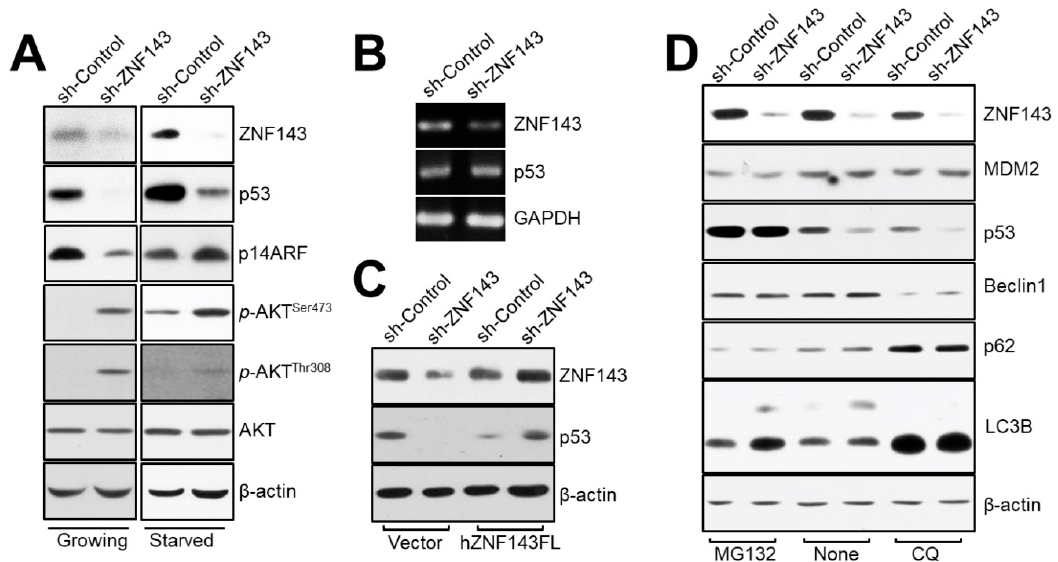
Figure 4. The p53 protein is altered in MCF7 sh-ZNF143 cells in a proteasome-dependent manner. ( A ) Growing or FBS-starved cells were harvested and subjected to immunoblotting. ( B ) Growing cells were harvested for RT-PCR. ( C ) Growing cells were transfected with pFLAG-CMV-hZNF143 or empty vector for 24 h and harvested for immunoblotting. ( D ) Growing cells were harvested for immunoblotting. Cells were treated with MG132 (20 µ M, 6 h), chloroquine (50 µ M, 18 h), or vehicle. The results shown are representative of at least three independent experiments.